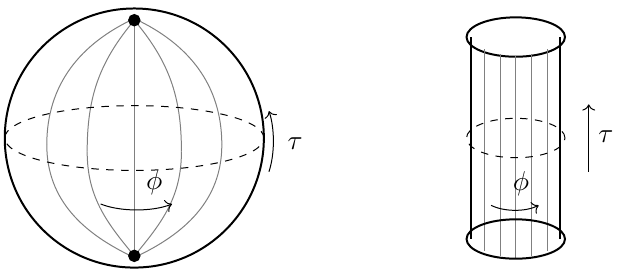
Figure 1 . The cylinder coordinates τ and φ defined through (1.4) map the celestial sphere onto the celestial cylinder. We will argue that the CCFT dynamics in the τ direction exhibits maximal quantum chaos.